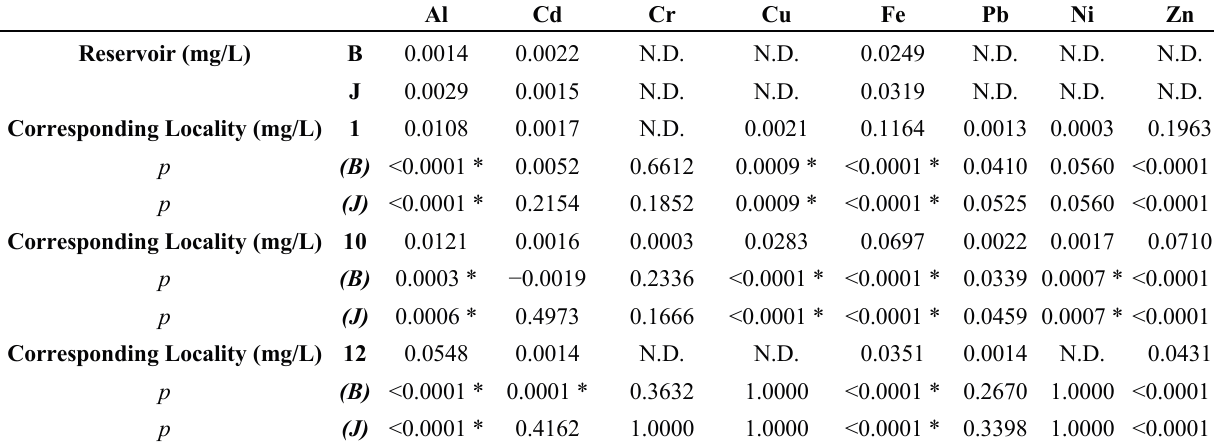
Table A4. Statistical variation between Reservoirs B and J and their feeding Localities 1, 10, 12, 23, 29,